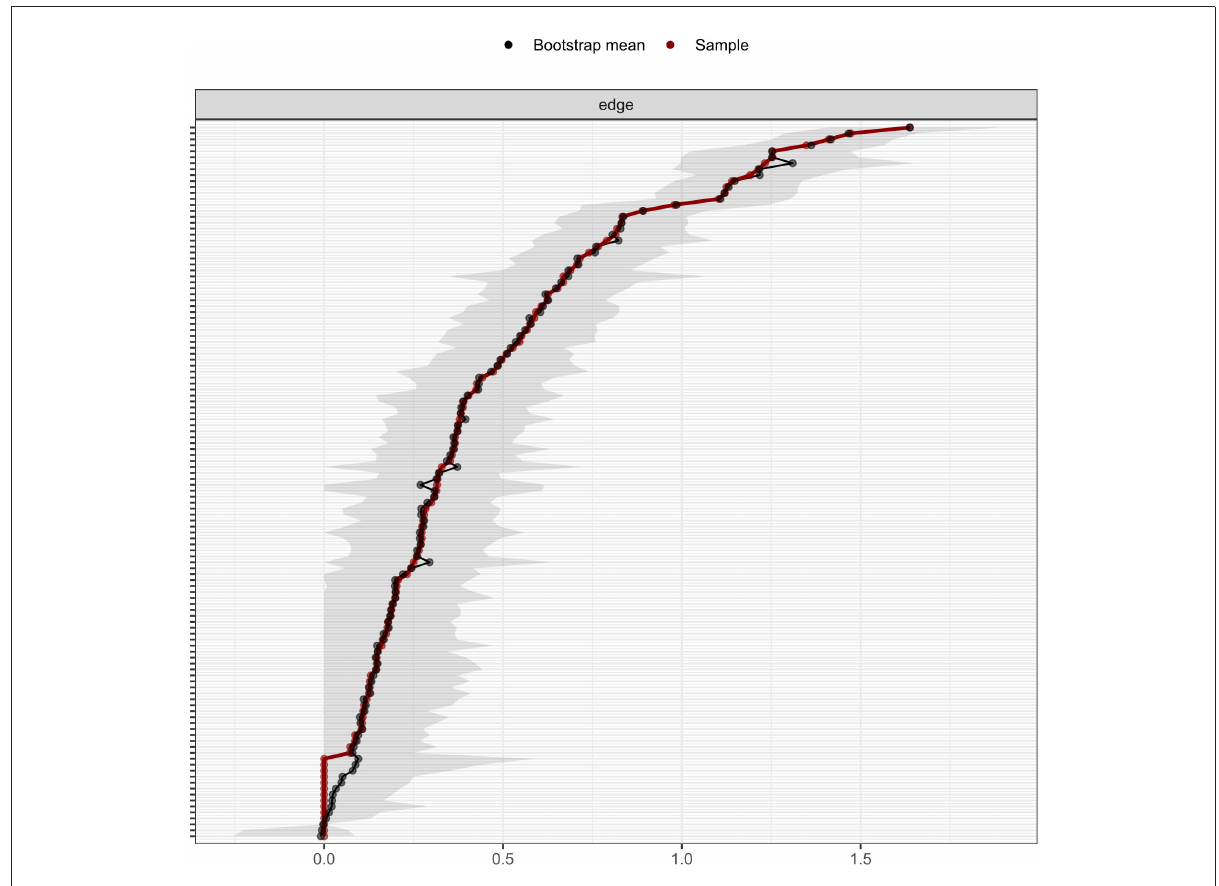
FIGURE5 The accuracy of the network edges by non-parametric bootstrapping. The gray area represents the bootstrap 95% confidence